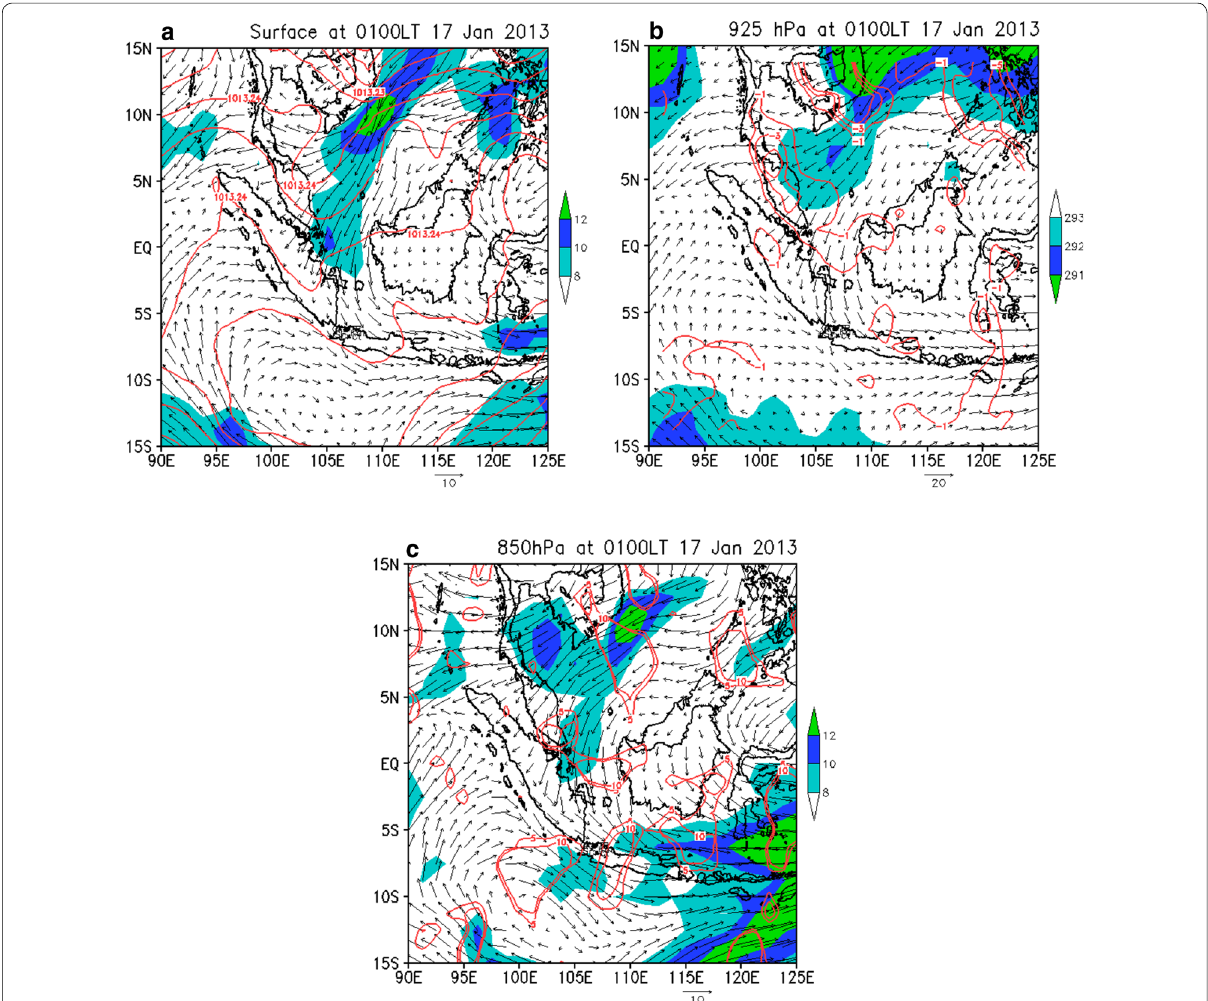
Fig. 12 As in Fig. 11 but valid for the second MCS